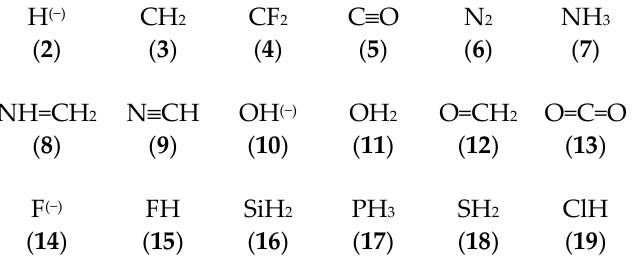
Scheme 1. The chosen set of molecules acting as Lewis base (LB) and forming a tetrel bond with the C atom from carbenoid ( 1 ) according to Figure 1c.